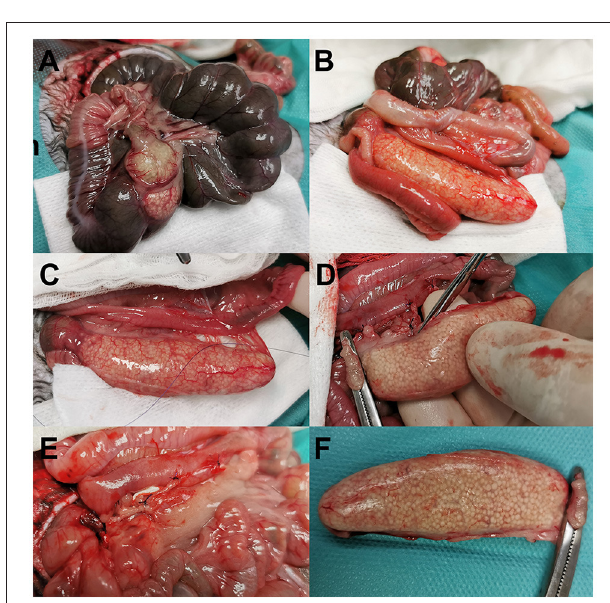
FIGURE 2 | Intra-operative view of the 16-month-old rabbit with both a sacculitis and appendicitis (A–F) . Exploratory laparotomy showed a thickened wall of both the sacculus rotundus (A) and the vermiform appendix (B) . During appendectomy, all the vessels associated with the appendix were ligated (C) prior to excision of the appendix (D) . Postoperative view of a caecum after appendectomy (E) and excised vermiform appendix (F)